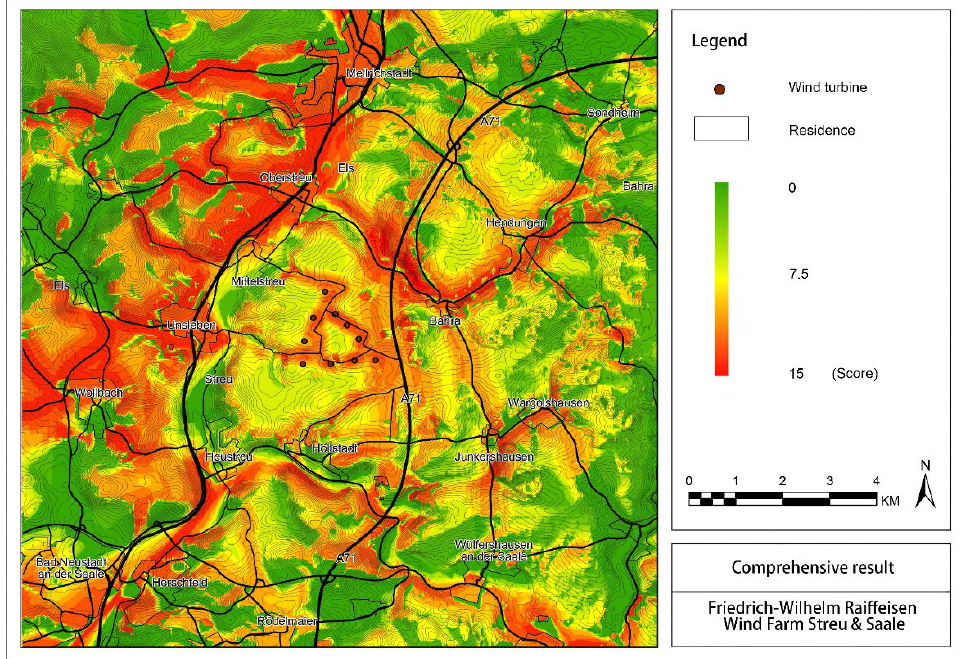
Figure 7. Comprehensive results of landscape visual impact evaluation. Most villages and towns are partly affected, and the visual impacts are unequally distributed according to the terrain and vertical structures. The villages of Unsleben, Ober‑ streu, and Bahra, the north part of Mittelstreu and Wollbach, the southeast part of Heustreu, the west part of Hollstade suffer from the severe visual impact. Except for these parts, other areas can only see the blade tip of the WTs, which poses no threat to the inhabitants’ daily life. Although the WTs are surrounded by farmland (Figure 7) that accounts for two‑thirds of the research area, the mean score of visual impact in farmland (2.86) is lower than that in towns (3.46), forests (2.94), industrial land, and infrastructure facilities (3.37). The